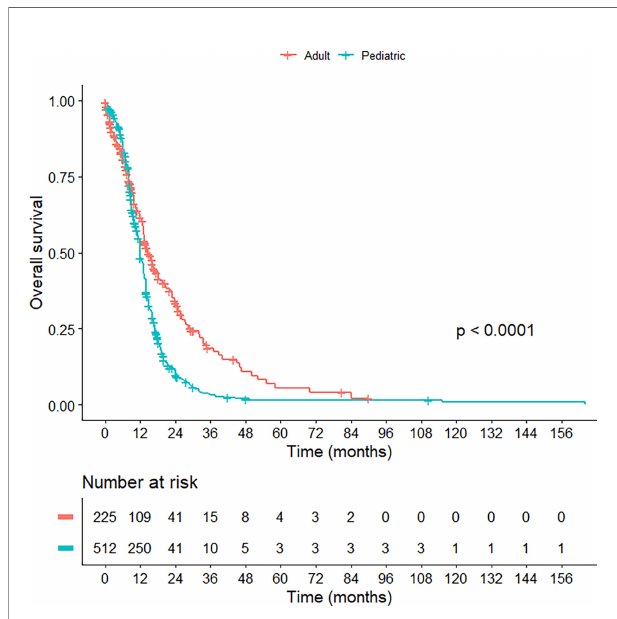
FIGURE 2 | Kaplan-Meier curve illustrating the overall survival of pediatric versus adult H3 K27M-mutant midline gliomas.